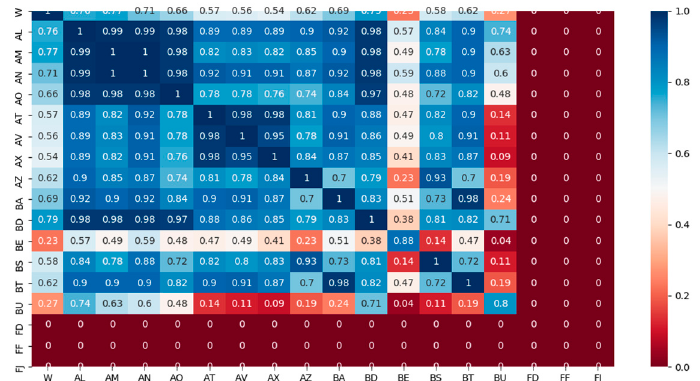
Figure 4. Correlation analysis of dataset 2.